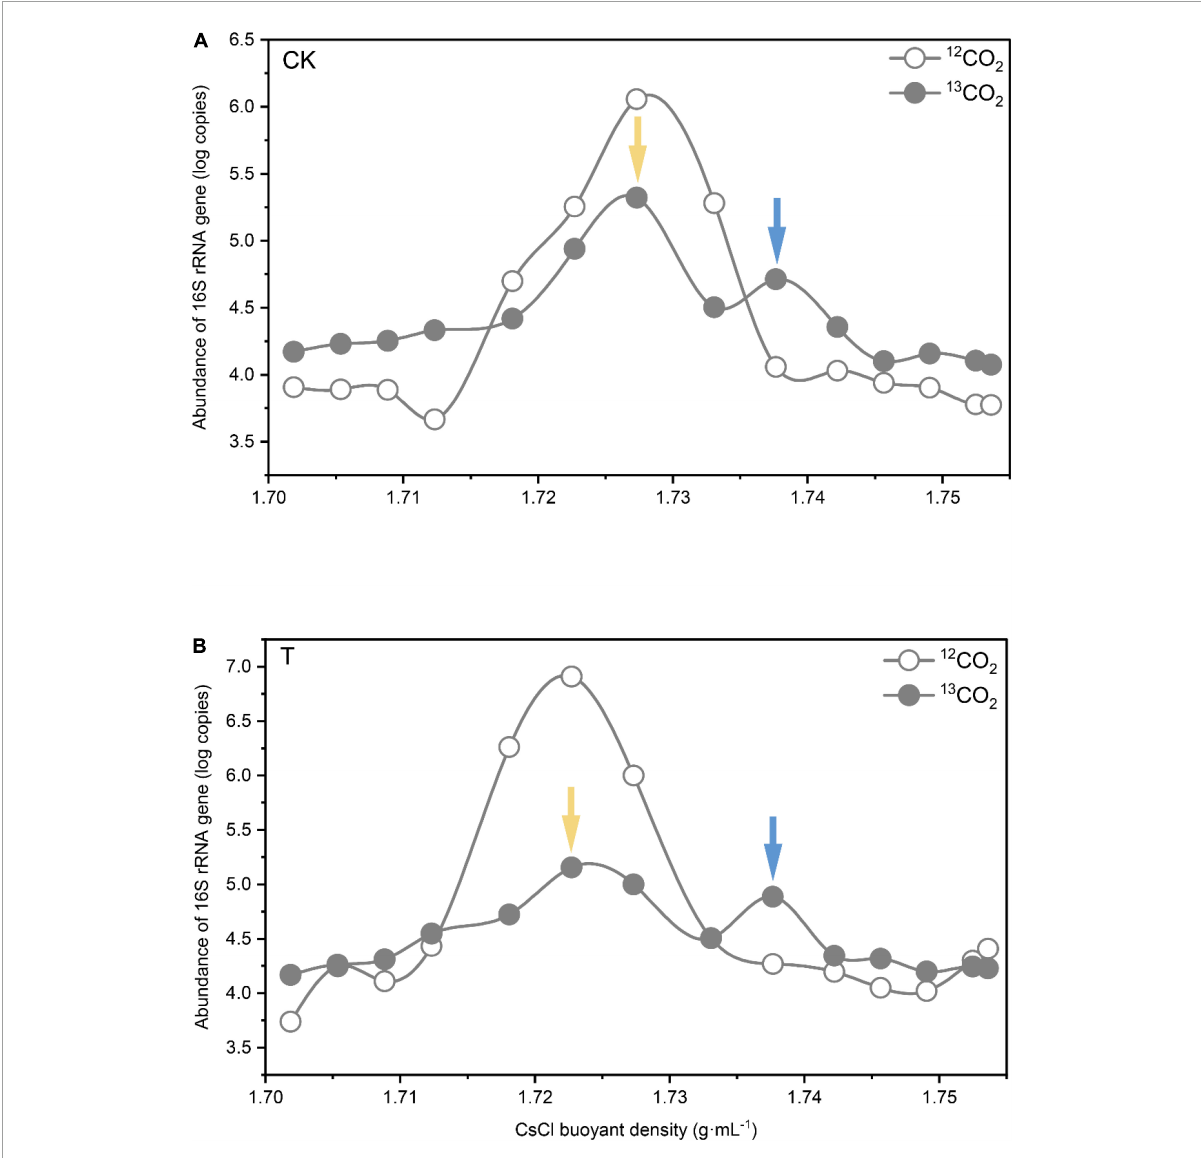
FIGURE3 Quantitative distribution of bacterial 16S rRNA gene copy numbers across the entire buoyant density gradient of the fractionated DNA from the rhizosphere soil incubated with 13 CO 2 or 12 CO 2 after CK (A) and 4-HBA treatment (B) . The values given are the means of three separate treatments. The blue and yellow arrows indicate the locations of 13 C-and 12 C-labeled DNA, respectively, which were used to construct amplicon libraries for high-throughput pyrosequencing.